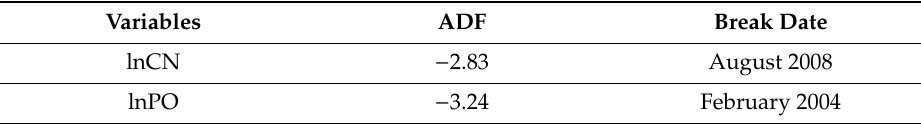
Table 3. Results of unit root with break